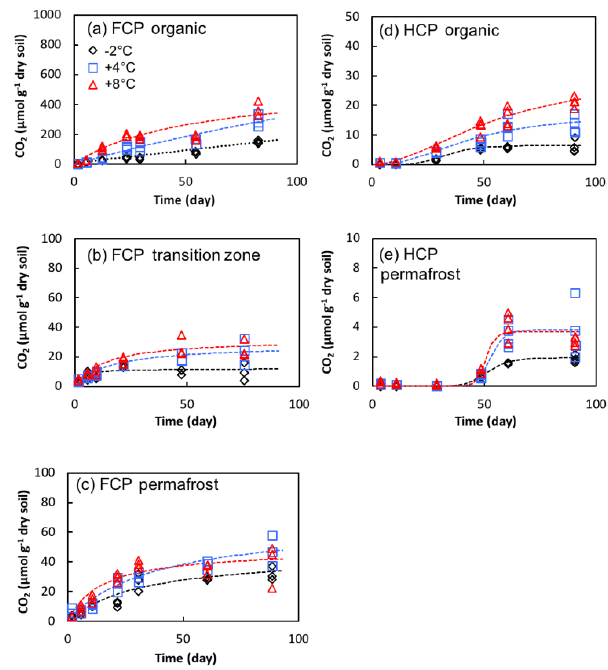
Figure 6. Cumulative CO 2 production in soil microcosms from FCP and HCP samples at indicated